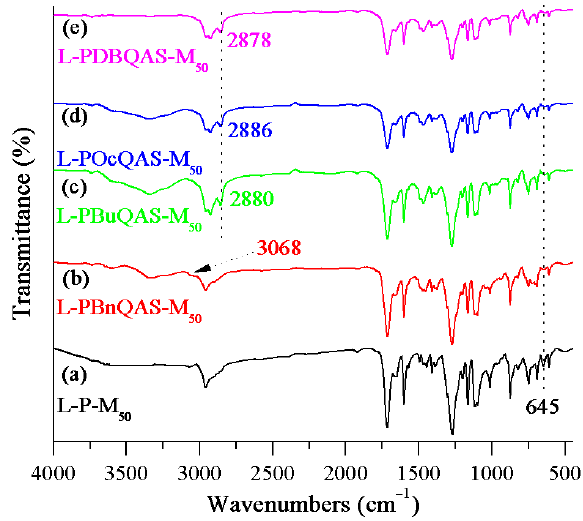
Figure 2. FT-IR spectra of the L-P-M 50 and L-PQASs. Table 2. Water solubility of the eight L-PQASs and its minimum inhibitory concentrations (MICs) against E. coli and S.